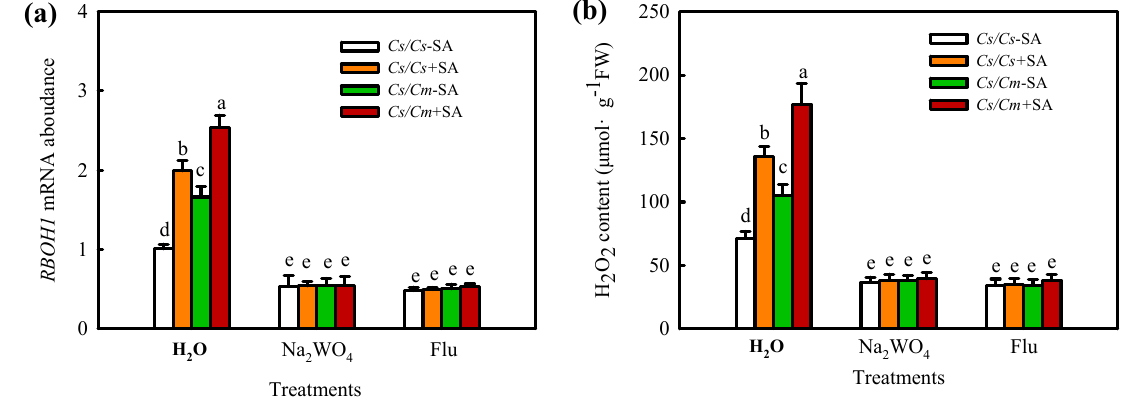
Figure 8. Effect of Na 2 WO 4 and Flu on SA − induced RBOH1 mRNA abundance ( a ) and H 2 O 2 accumulation ( b ) in grafted cucumber plants. Plants were treated with 3 mM Na 2 WO 4 , 50 µ M Flu, or deionized water, and 8 h later, 1.0 mM SA was sprayed. At 12 h after pretreatment, the plants were exposed to 5 °C for 6 h. Data are presented as the means ± SD ( n = 3). Different letters indicate a statistical significance between samples at p < 0.05.